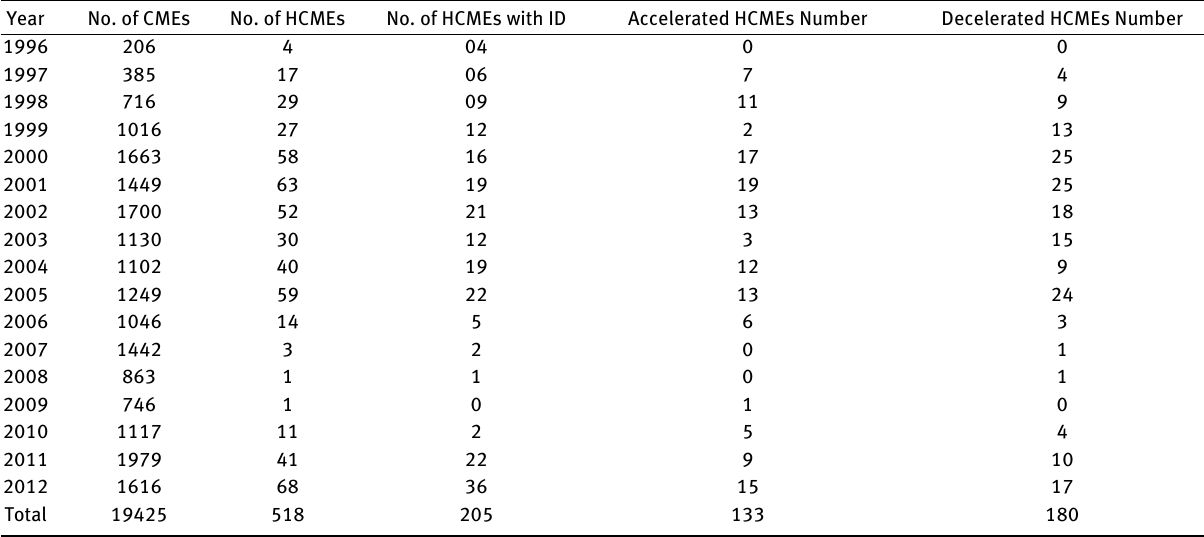
Table 1. Number of CMEs, Number of HCMEs, Number of HCMEs with ID, Accelerated HCMEs Number and Decelerated HCMEs Number for Each Year During Period 1996-2012.